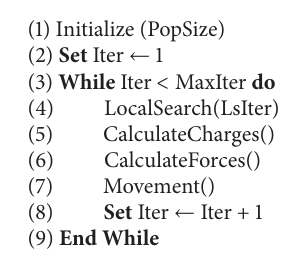
Algorithm 1: EMA (PopSize, MaxIter, and